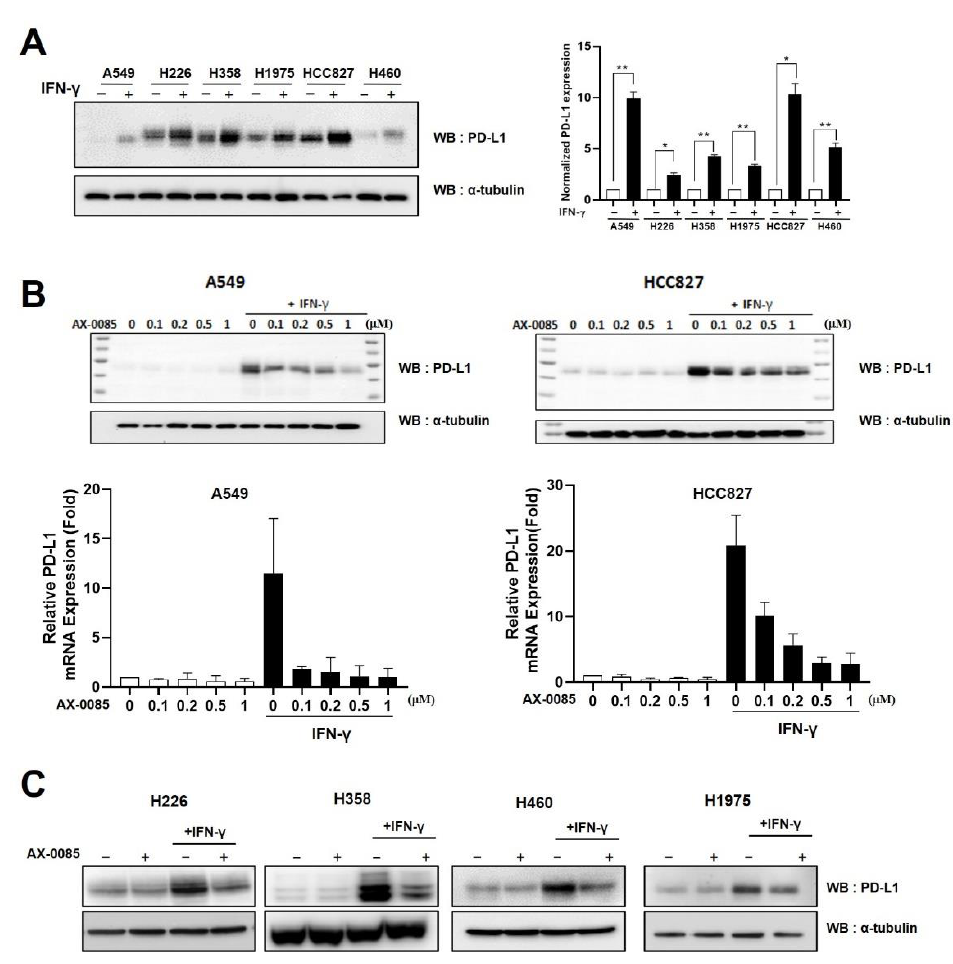
Figure 2. AX-0085 inhibits IFN- γ -induced PD-L1 expression. ( A ) Immunoblots showing up-regulation of PD-L1 expression with the addition of IFN- γ at 20 ng/mL for 24 h. LUAD cell lines used are indicated. ɑ – tubulin was used as the loading control. The graph on the right shows the results from the quantitative real time RT-PCR assay. Data are mean ± SEM of three independent experiments. Statistical significance is indicated (* p -value of <0.05, ** p - value of <0.01 from Student’s t -test). ( B ) Immunoblot showing inhibition of IFN- γ -induced PD-L1 up-regulation by AX-0085 in a concentration-dependent manner in A549 and HCC827 cells. Cells were treated with 20 ng/mL of IFN- γ for 24 h prior to application of indicated levels of AX-0085 for another 24 h. ɑ – tubulin was used as the loading control. Graphs at the bottom show results from the quantitative real time RT-PCR. Data are mean ± SEM of three independent experiments. Statistical significance is indicated (* p -value of <0.05, ** p - value of <0.01 from Student’s t -test). ( C ) Immunoblots showing changes in PD-L1 expression induced by sequential addition of IFN- γ (20 ng/mL) and AX- 0085 (0.5 μM) as in ( B ). LUAD cell lines used are indicated. ɑ – tubulin was used as the loading control.